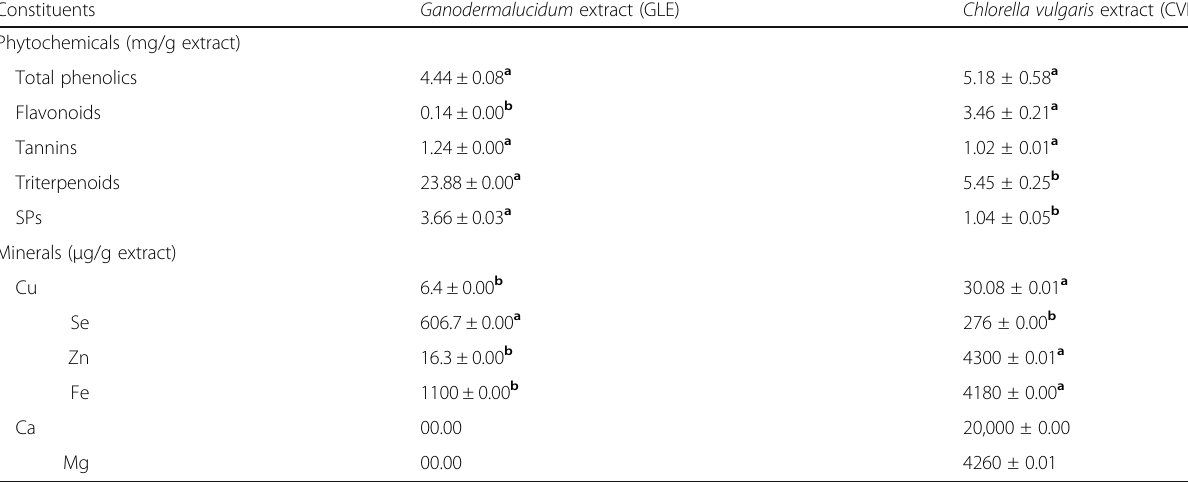
Table 1 Phytochemicals and minerals composition of the studied extracts